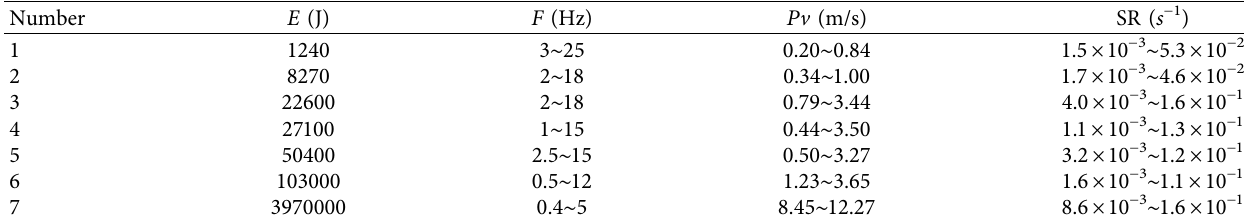
Table 3: Range of the dynamic load strain rate of coal mine dynamic disasters.